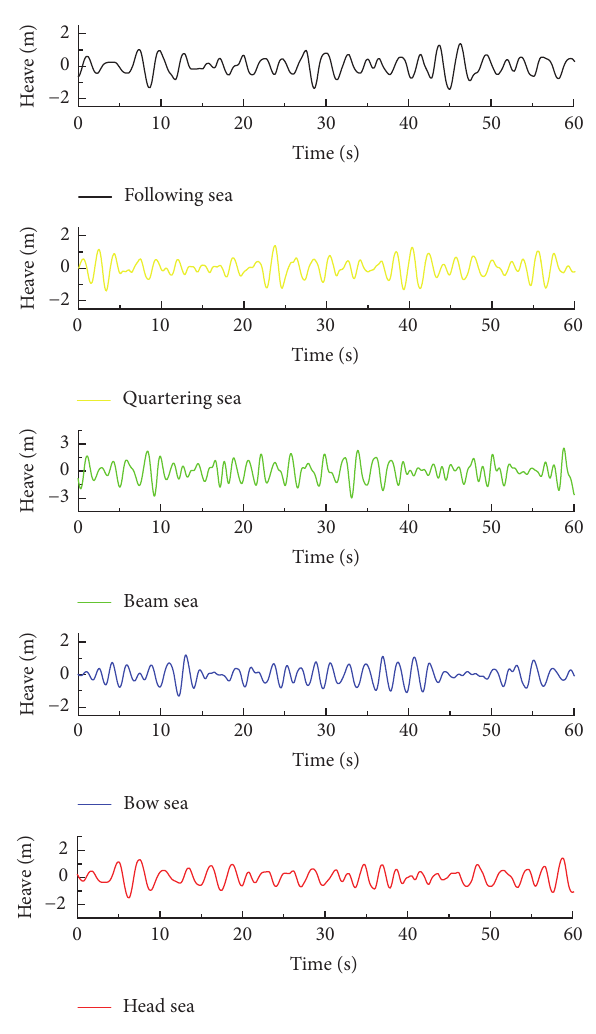
Figure 11: Time histories of heave in irregular waves.